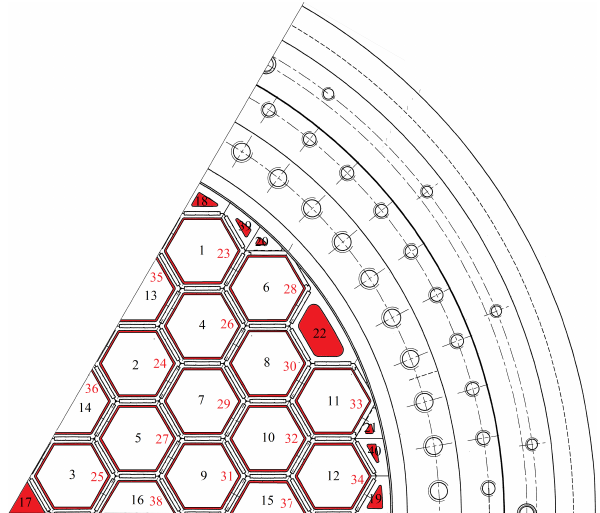
Figure 6. One sixth of the modeled SC with sub- channel numbering. There were 12 full-assemblies (No. 1-12), 4 half-assemblies (No. 13-16) and 24 empty channels filled with He (No. 17-40) imple- mented into the